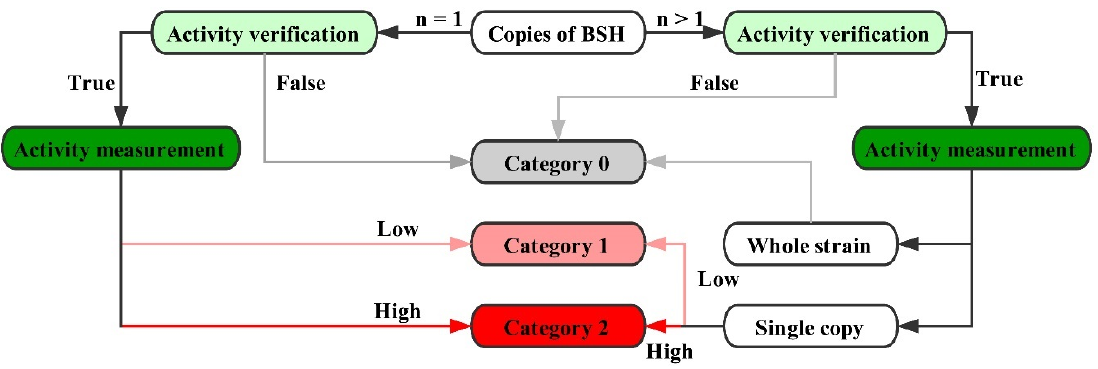
Figure 1. Scoring rules of BSH.